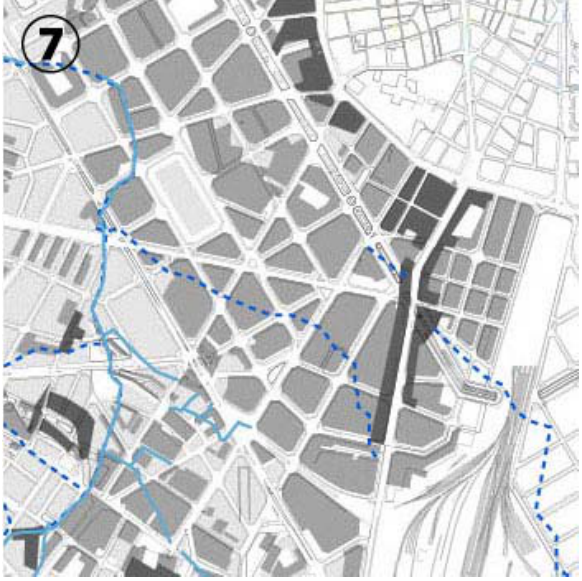
Figure 12. In the area labeled ⑦ , the canals disappeared during the period between 1883 and 1946.